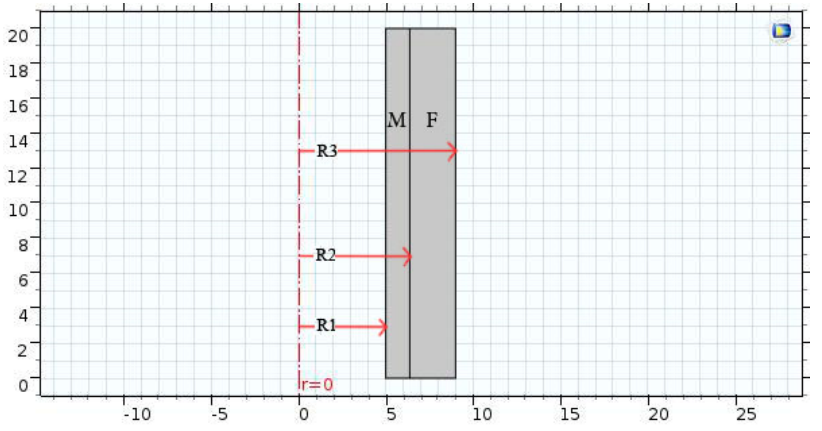
Fig. 3 Geometry of the PV system used in the simulation Fig. 3: Geometry of the PV system used in the